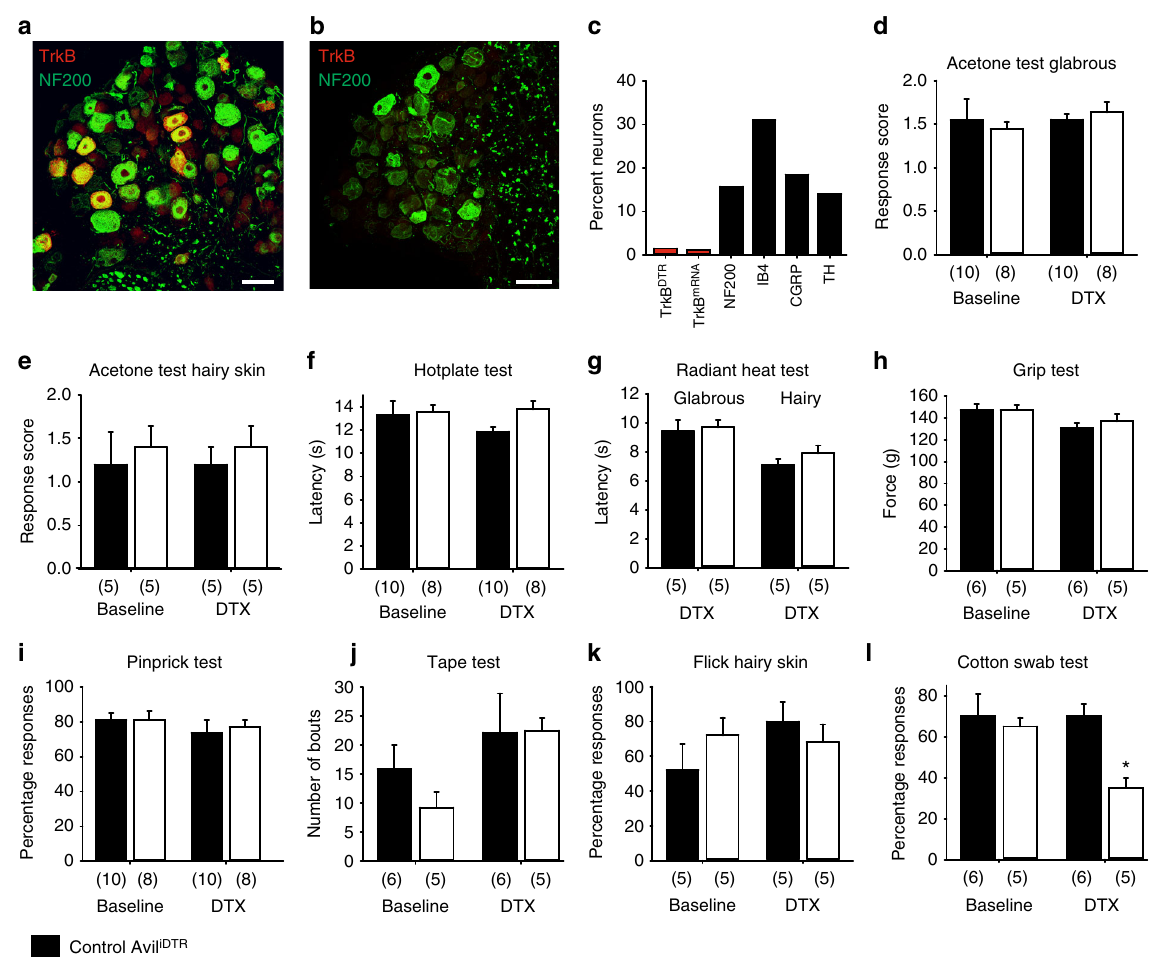
Fig. 3 Diphtheria toxin-mediated ablation of TrkB + sensory neurons. Immunostaining of DRG sections of TrkB CreERT2 ::Avil iDTR mice with an antibody against the diphtheria toxin receptor (red) from a untreated mice and b after i.p. injections of diphtheria toxin. c Quanti fi cation of DRG sections indicating a ~90% decrease in TrkB DTR and TrkB mRNA cells after ablation and 36% reduction in NF200 + neurons without affecting other subpopulations. d – l Behavioral responses in littermate control mice (Avil iDTR , black bars) and TrkB CreERT2 ::Avil iDTR mice (white bars) showing no differences in responses before and after ablation in the acetone drop test ( t -test; p = 0.800) on d glabrous and e hairy skin, f hot plate test ( t -test; p = 0.914), g radiant heat test on glabrous and hairy skin ( t -test; p = 0.263), h grip test ( t -test; p = 0.484), i pin-prick test ( t -test; p = 0.691), j tape test ( t -test; p = 0.776), and k punctate mechanical fl ick test applied to the hairy back skin ( t -test; p = 0.196). l Ablated mice show a reduction in sensitivities to cotton swab ( t -test, p = 0.002). Scale bars in a , b 50 μ m, error bars